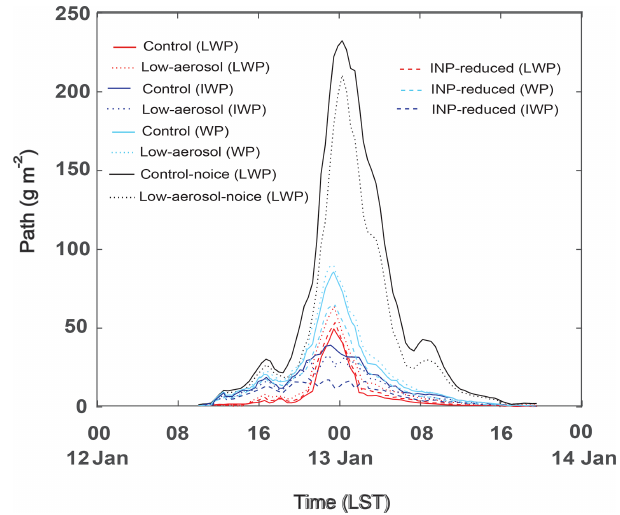
Figure 14. Time series of the domain-averaged LWP, IWP, and WP for the control, low-aerosol, and INP-reduced runs and LWP, which is also WP, for the control-noice and low-aerosol-noice